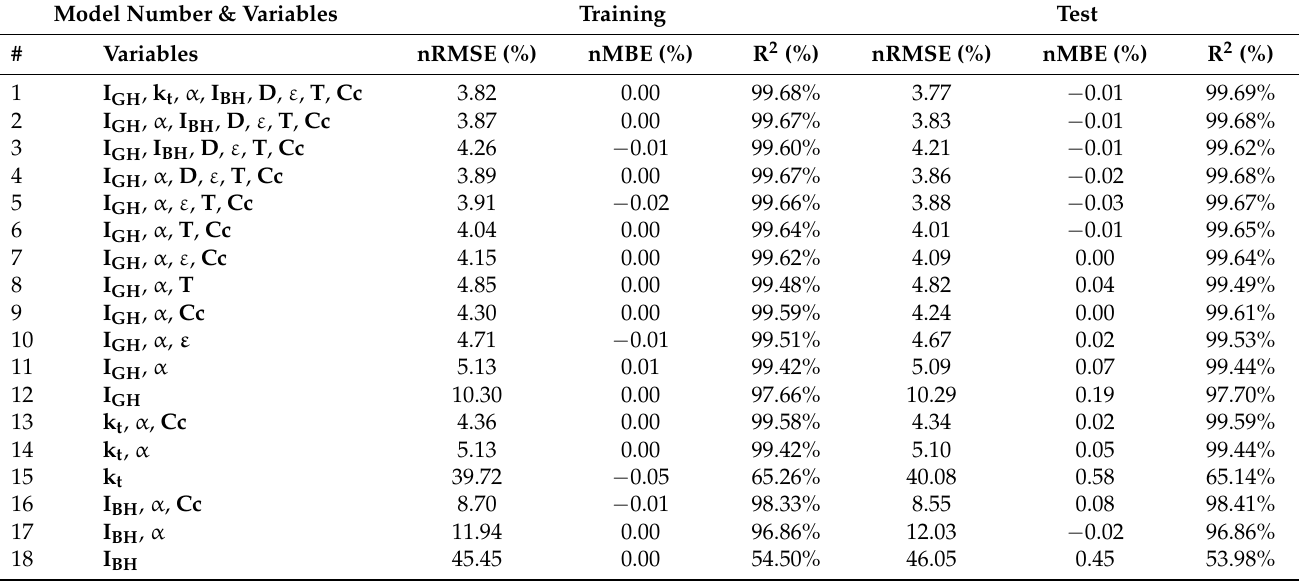
Table 3. Results of I UV ANN